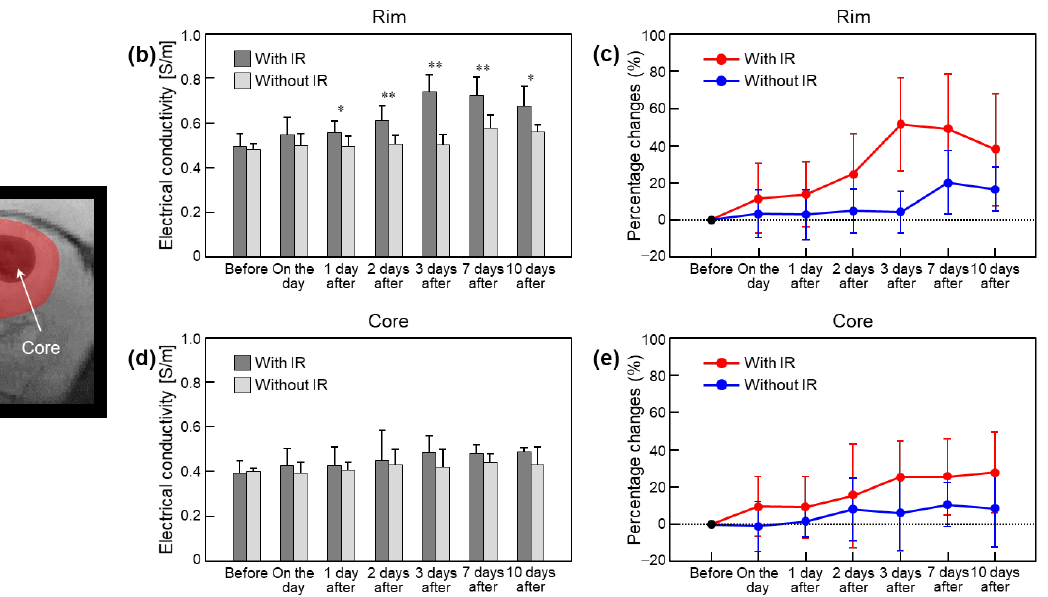
Figure 6. Comparison of absolute conductivity and percentage changes in mouse brain tumor tissues with and without irradiation. ROIs ( a ) were located in the rims and cores of tumor regions at full time points. Bar graph ( b , d ) indicates measured absolute conductivity in tumor tissues after irradiation. Line graph ( c , e ) indicates percentage changes of conductivity in tumor tissues after irradiation. Statistical significances were compared between irradiated and non-irradiated groups (* p < 0.05, ** p < 0.01).